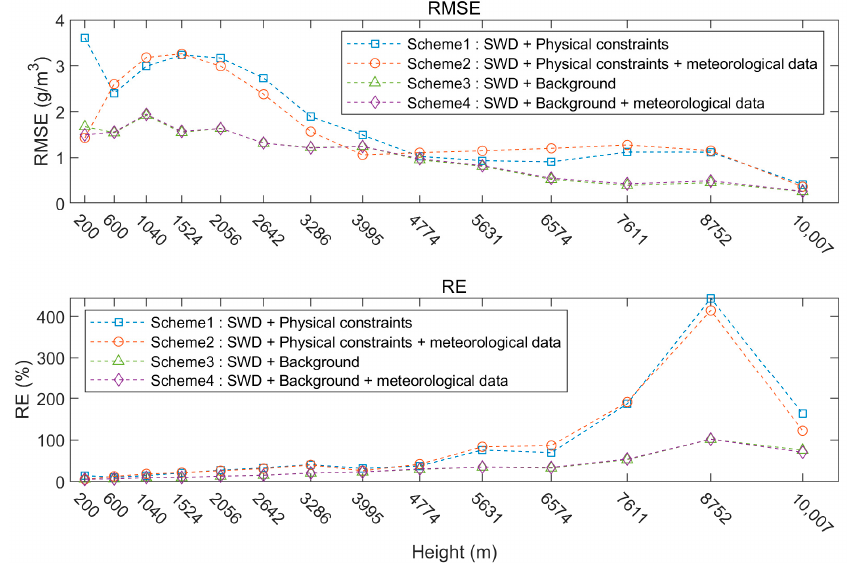
Figure 2. Statistical results of RMSE and RE during the experiment period at each tomographic layer and four tomographic schemes.